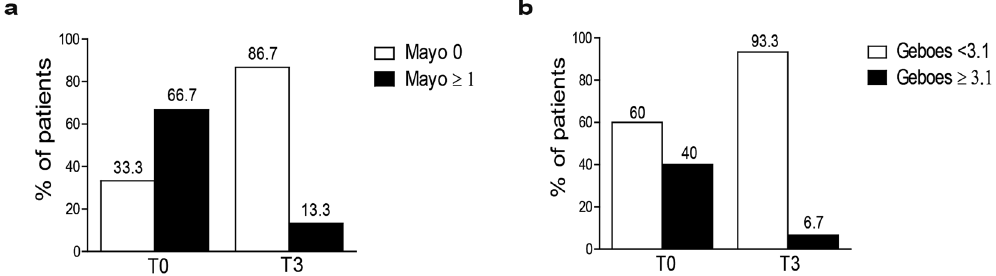
Figure 2. ( a ) Mayo endoscopic score and ( b ) Geboes histological score in compliant and responder patients (n = 15) at T0 and T3. Data are presented as percentage of patients according to Mayo and Geboes